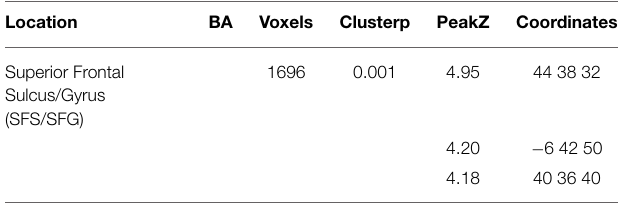
Thresholdedatavoxel-wisep < 0.005andcorrectedformultiplecomparisonsbyacluster level p < 0.05. This is one cluster that contains the bilateral SFS/G.